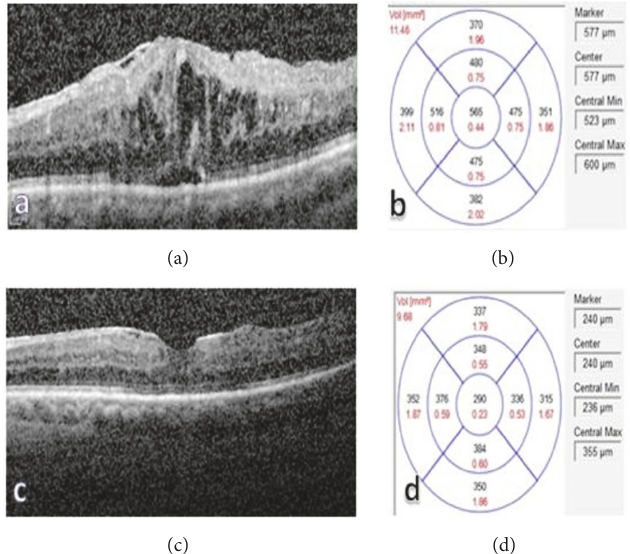
Figure 2: (a)-(b) Optical Coherence Tomography image showing the macular edema before Ozurdex injection (CMT: 565 𝜇 m). (c)-(d) Optical Coherence Tomography images 85 days after the following Ozurdex administration showing resolution of the macular edema (CMT: 290 𝜇